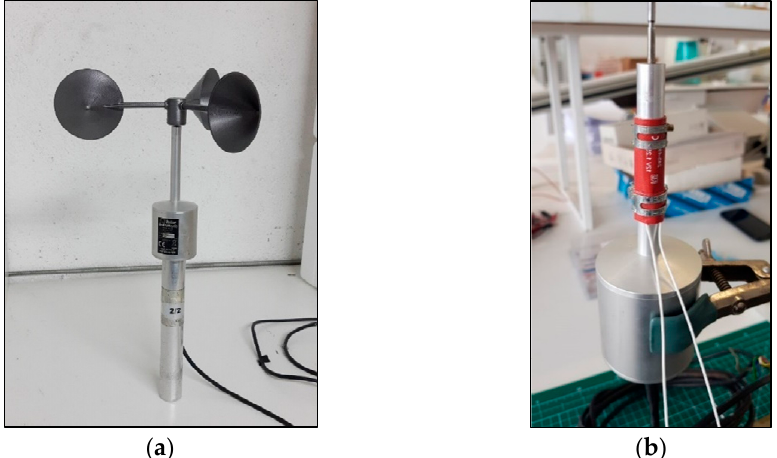
Figure 2. ( a ) TASEC-Lab cup anemometer. Rotor designed at the IDR/UPM Institute mounted on the body of the Vector Instruments A100 L2 cup anemometer; ( b ) Heater resistor and thermocouple installed on the body to preserve the temperature within the proper limits during the TASEC-Lab flight.